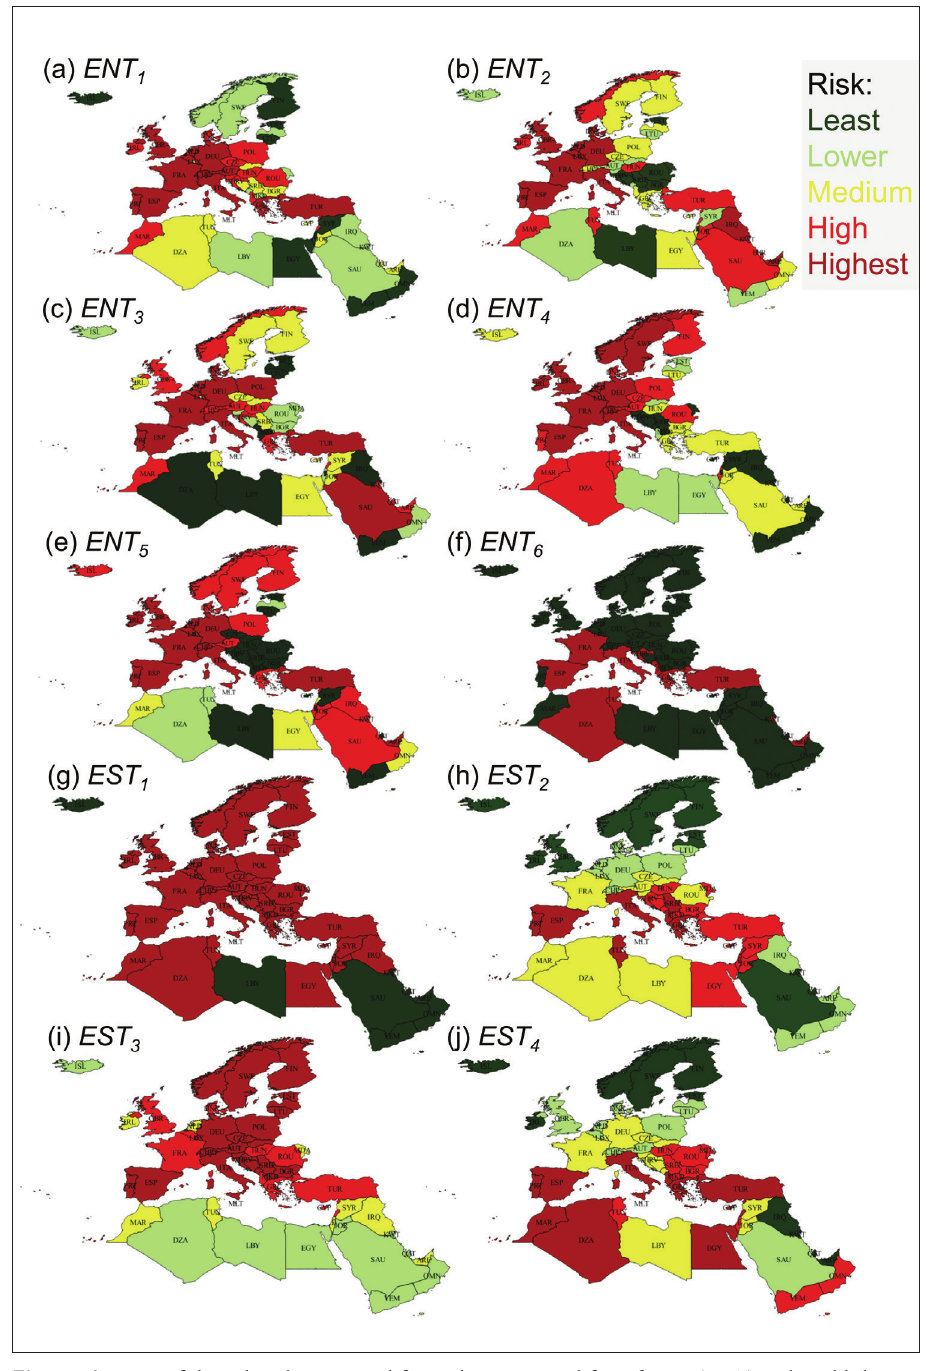
Figure 4. Maps of the risk indicators used for ranking potential for Xf entry ( ENT ) and establishment and spread ( EST ) as described in Table